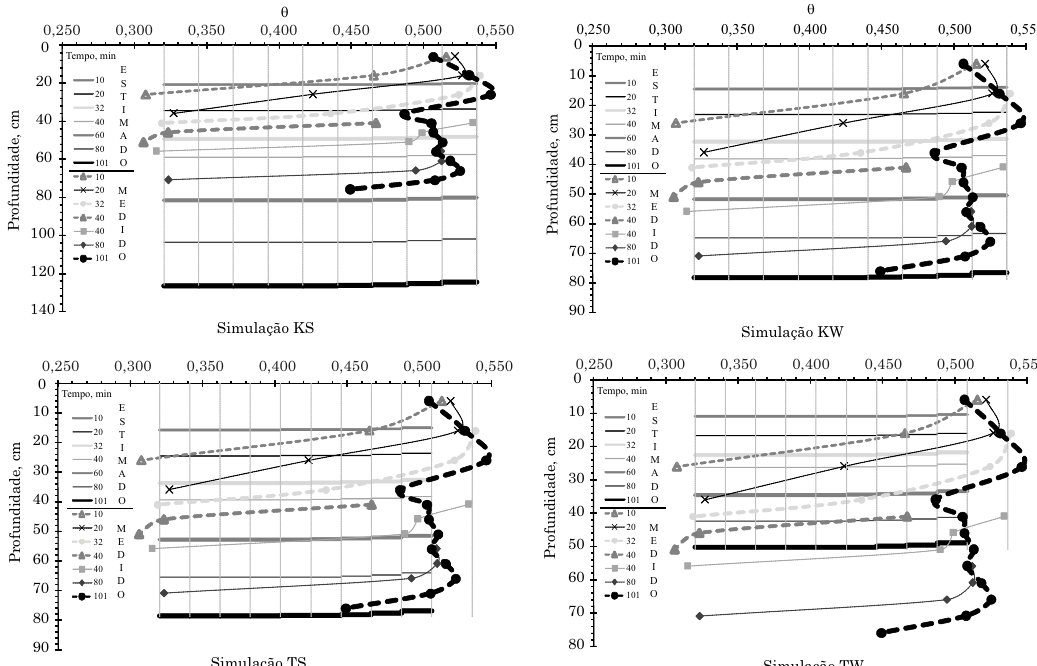
Figura 6. Perfis de umidade medidos e estimados com o GAML-c no 2º teste